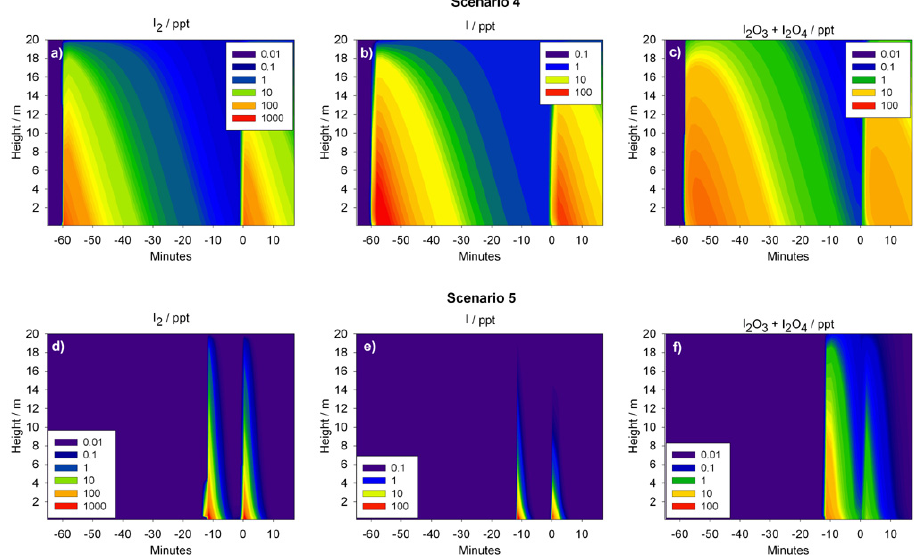
Fig. 5. Vertical distributions of (a) I 2 , (b) I and (c) I 2 O 3 +I 2 O 4 in scenario 4, with 50% cloud cover and fast mixing close to the surface and (d) I 2 , (e) I and (f) I 2 O 3 +I 2 O 4 in scenario 5 with an unknown chemical loss for I atoms. The air mass travelling over the bay arrives at the measurement site at time 0 with a local injection at − 10s. A second injection point is considered at − 60min for scenario 4 and − 12min for